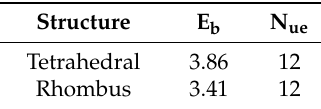
Figure 1. Tetrahedral ( a ) and rhombus ( b ) structures of Co 4 cluster; key distances are given in Å. Table 1. The calculated binding energies (E b , eV/atom), the numbers of unpaired electrons (N ue ) of Co 4 clusters